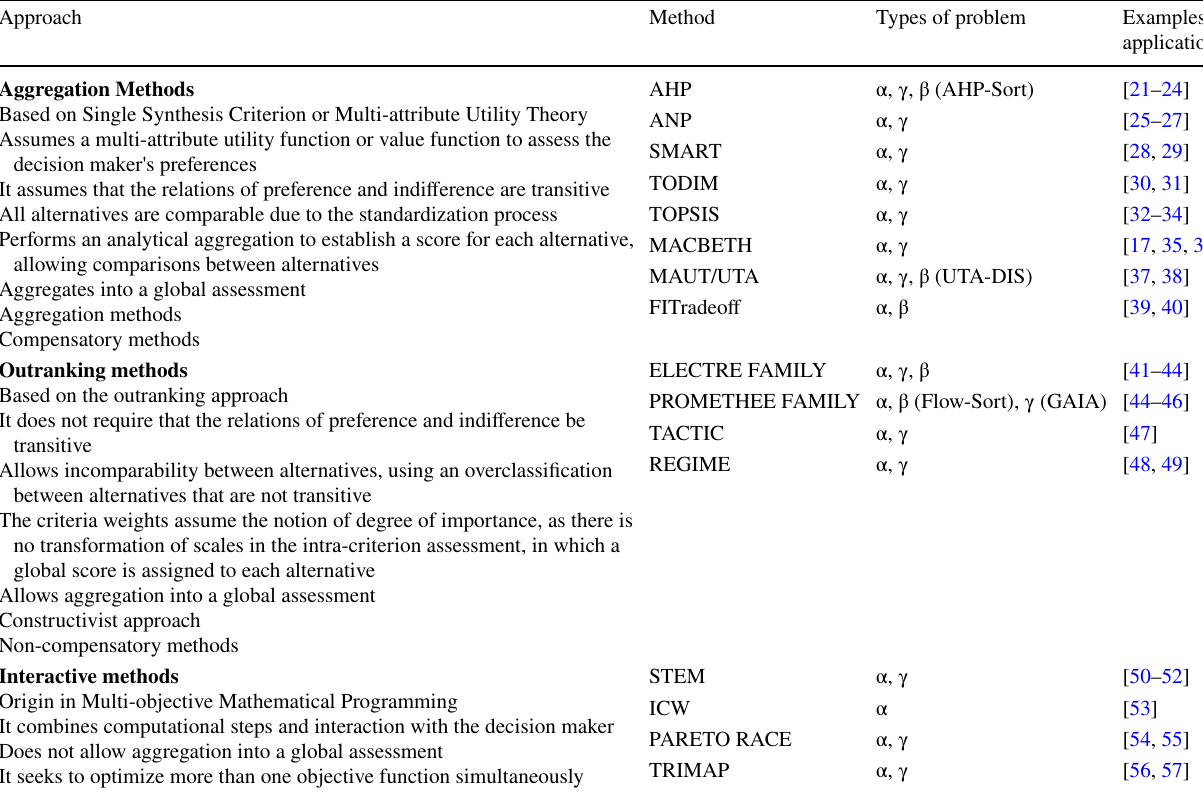
Table 1 Synthesis of multi-criteria methods Approach Method Types of